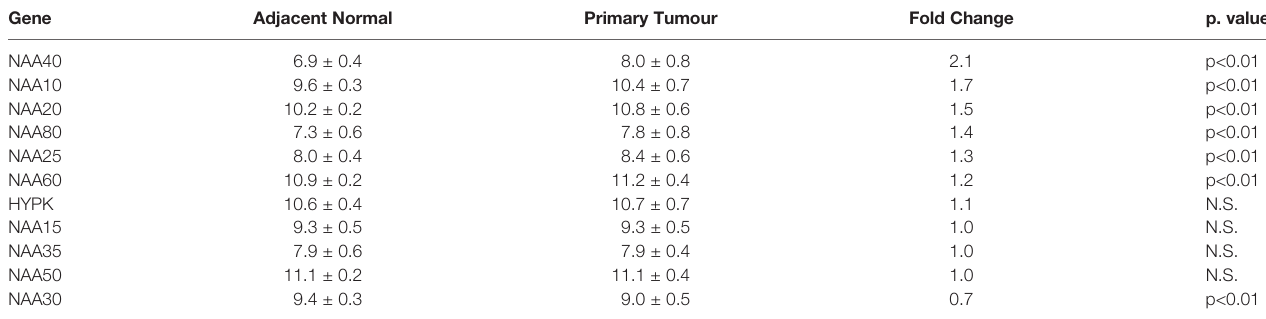
TABLE 2 | Comparison of NAT expression levels between adjacent normal and primary tumour tissue in TCGA LIHC dataset. Gene Adjacent Normal Primary Tumour Fold Change p.